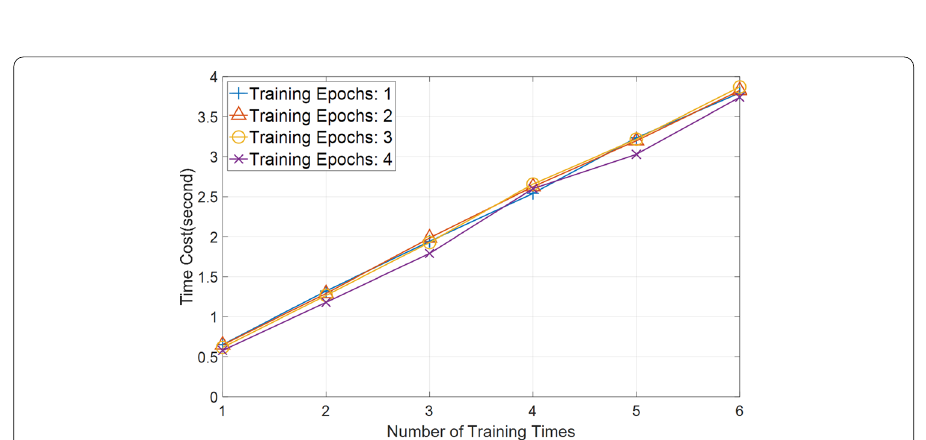
Fig. 19 The time cost of discriminating the DCTF. This figure depict the relationship between time costs of discriminating the DCTF and the number of training times under different numbers of training